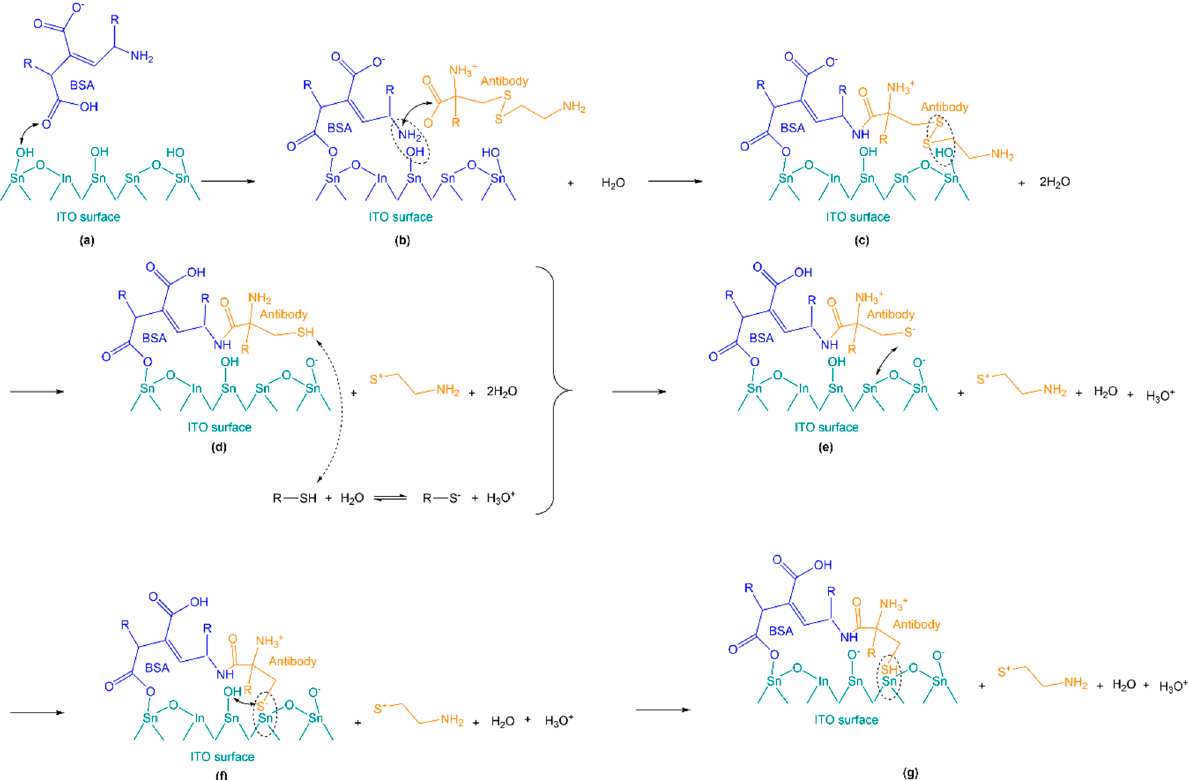
Figure 7. The proposed catalytic reactions on the ITO surface: ( a ) The reaction of the BSA on the surface of ITO is due to the reaction of hydroxyl groups with the C=O bond (SnOC = O). ( b ) Adding the antibody in BSA to the surface of the ITO results in the conjugation of the antibody protein. ( c ) The protons on the surface of the ITO, react with the antibody’s S-S bonds close to the surface. ( d ) Breaking S-S bonds in antibody to -SH and R-S + due to denaturation of antibody by catalytic reactions of the remaining hydroxyl groups on the surface. This results in the creation of thiolate anion (R-S − ) due to the chemical reaction of thiol with a water molecule on the surface. ( e ) The antibody approaches the Sn atom on the ITO surface through R-S − after formation of thiolate anion. ( f ) The proton from hydroxyl groups on the surface moves to thiolate anion in the antibody. ( g ) Generating the negative charges on the surface of the ITO decreases the surface resistance of the ITO.